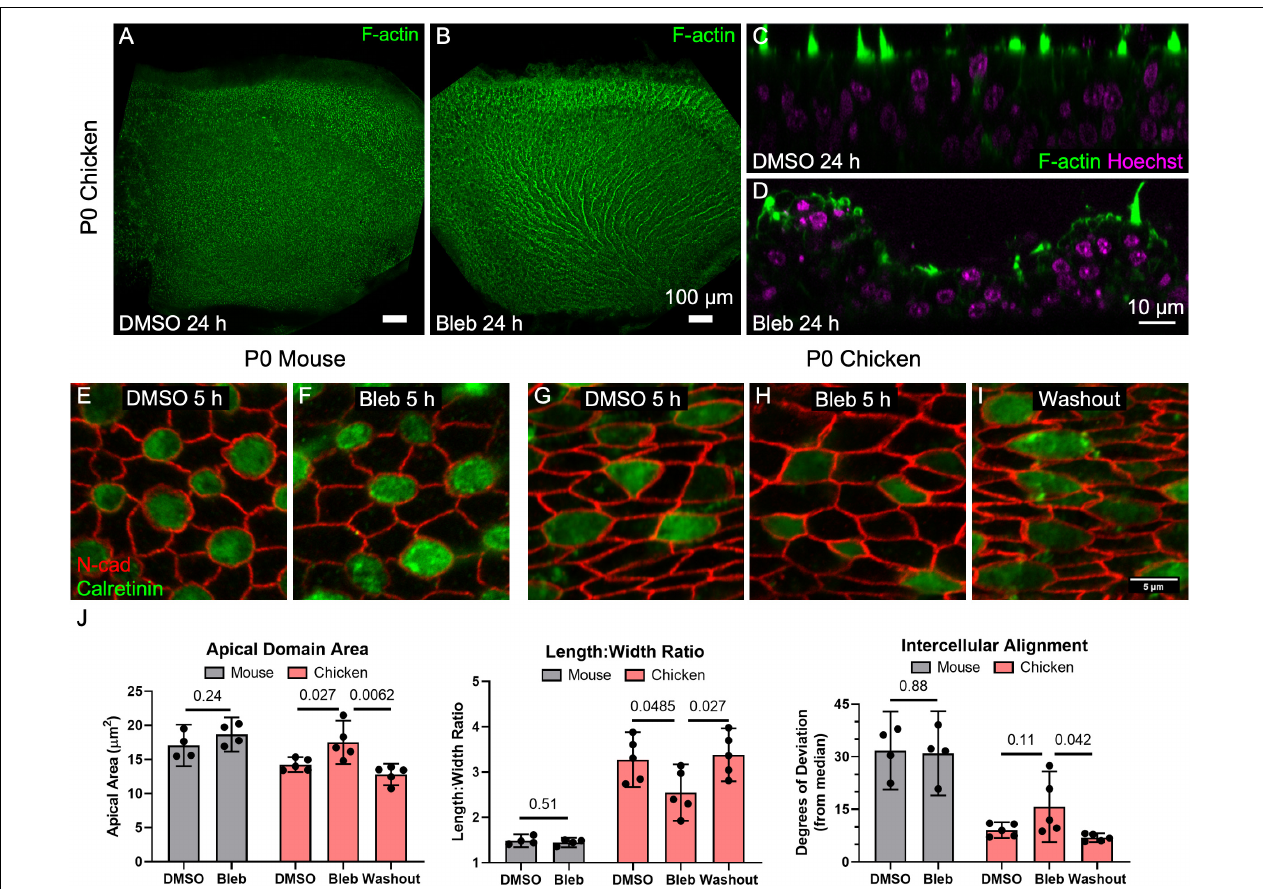
FIGURE 5 | Inhibition of non-muscle myosin II activity led to dramatic expansion of SC apical domains in utricles of P0 chickens but had no detectable effect on the shapes of SCs in P0 mouse utricles. (A,B) Chicken utricles were cultured for 24 h in the presence of DMSO (A) or 50 µ m blebbistatin (B) . Blebbistatin treatment resulted in a “ruffled” appearance of the epithelial surface. (C,D) Z-projections depicting buckling of the epithelium after blebbistatin treatment. (E–I) Utricles from P0 mice and P0 chickens were cultured for 5 h in the presence of 50 µ M blebbistatin or DMSO vehicle control before fixation. Some blebbistatin-treated utricles of P0 chickens were rinsed and fixed after a total of 16 h (Washout, I ). (J) Quantification revealed that in SCs of mouse utricles, blebbistatin treatment did not lead to significant differences in apical domain area ( p = 0.24, t ( 6 ) = 1.30, unpaired t -test, n = 4 utricles per condition), length:width ratio ( p = 0.51, t ( 6 ) = 0.70, unpaired t -test, n = 4 utricles per condition), or intercellular alignment ( p = 0.88, t ( 6 ) = 0.15, unpaired t -test, n = 4 utricles per condition) compared to controls treated with DMSO. In contrast, blebbistatin treatment significantly affected SC area ( p = 0.027, t ( 8 ) = 2.7, n = 5 utricles per condition) and length:width ratio ( p = 0.0485, t ( 8 ) = 2.3, n = 5 utricles per condition) in chicken utricles, with alignment not reaching statistical significance ( p = 0.11, t ( 8 ) = 1.8, n = 5 utricles per condition). Upon washout of blebbistatin, changes to SC area ( p = 0.0062, t ( 8 ) = 3.7, n = 5 utricles per condition), elongation ( p = 0.027, t ( 8 ) = 2.3, n = 5 utricles per condition), and intercellular alignment ( p = 0.042, t ( 8 ) = 2.7, n = 5 utricles per condition) were reversible.